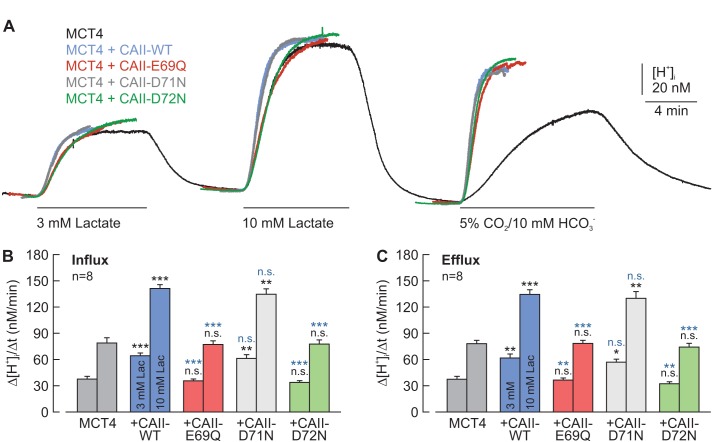
CAII-Glu69 and Asp72 are crucial for the facilitation of MCT4 transport activity.(A) Original recordings of the change in intracellular H+ concentration in oocytes expressing MCT4 (black trace), MCT4 + CAII-WT (blue trace), MCT4 + CAII-E69Q (red trace), MCT4 + CAII-D71N (gray trace), and MCT4 + CAII-D72N (green trace), during the application of 3 and 10 mM lactate and of 5% CO2 and10 mM HCO3–. (B, C) Rate of change in intracellular H+ concentration (Δ[H+]/Δt) as induced by the application (B) and the removal (C) of 3 and 10 mM lactate, respectively, in oocytes expressing MCT4 (dark gray), MCT4 + CAII-WT (blue), MCT4 + CAII-E69Q (red), MCT4 + CAII-D71N (light gray), and MCT4 + CAII-D72N (green) (mean + SEM). The black significance indicators refer to MCT4, the blue significant indicators refer to MCT4 + CAII-WT. *p≤0.05, p≤0.01, ***p≤0.001. n.s. no significance; Student’s t-test.